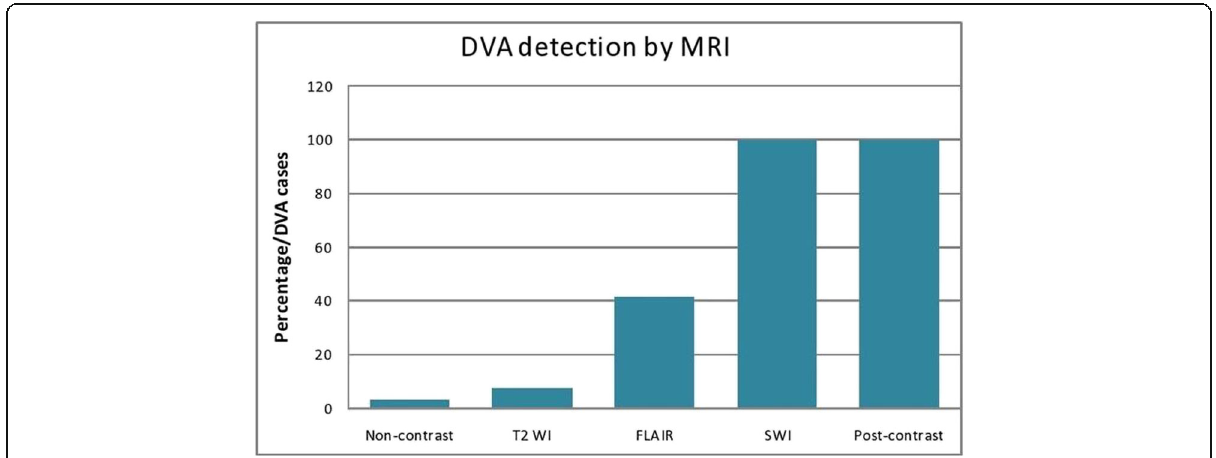
Fig. 2 Detection of DVA by different MRI sequences in relation to the T1W contrast enhanced